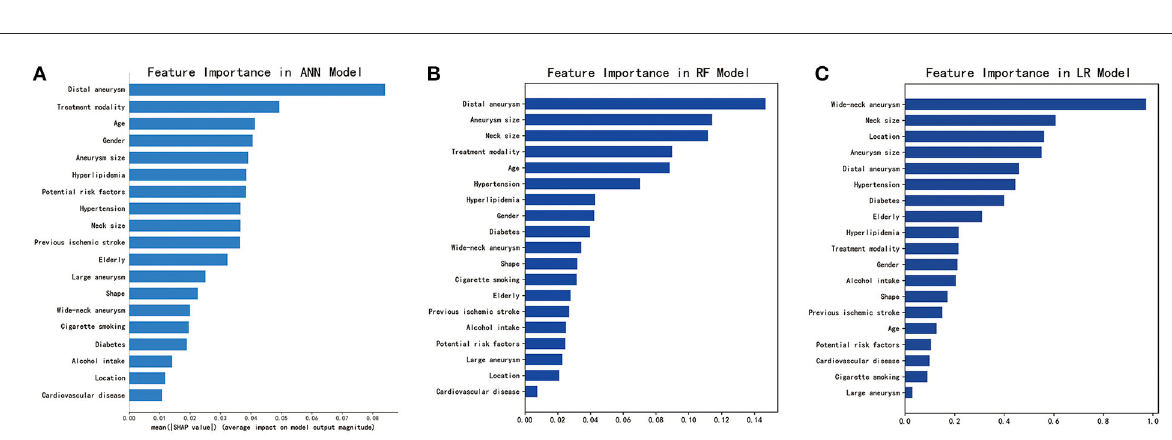
FIGURE2 Identification of important features for the three machine learning models. (A) SHAP analysis for the ANN model. (B) Feature importance analysis for the RF model. (C) Feature importance analysis for the LR model. ANN, artificial neural network; RF, random forest; LR, logistic regression. For categorical variables, gender (male), potential risk factors ( ≥ 2), location (posterior circulation), and shape (irregular) were analyzed as potential risk factors. Receiver operating characteristic (ROC) curves for the three machine learning models (ANN, RF, and LR) on the testing set. ANN, artificial neural network; RF, random forest; LR, logistic